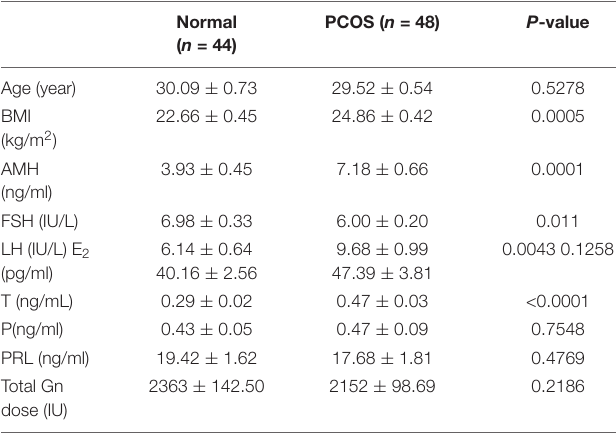
TABLE 1 | Clinical characteristics of the enrolled